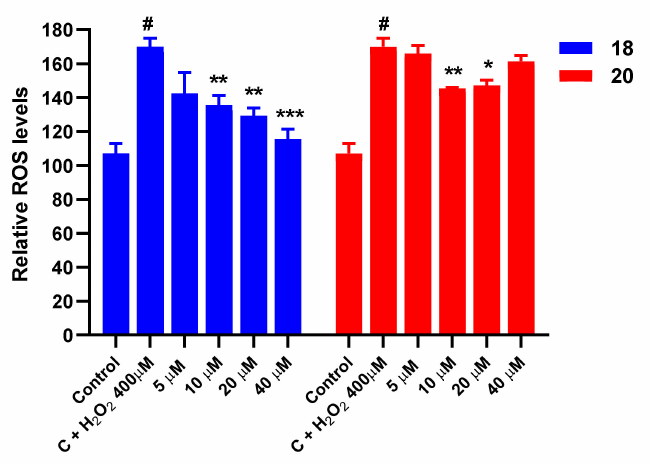
Figure 17. Intracellular ROS level reduction by compounds 18 and 20 in SH-SH5Y under 4-h treatment with 400 µ M H 2 O 2 . Cells were treated with 18 and 20 for 24 h prior to exposure to H 2 O 2 . ROS levels were evaluated by the DFCH-DA method. Data are presented as the Mean ± SEM of three independent experiments carried out in quadruplicate. # p <0.001 vs. vehicle-treated control. * p < 0.05, ** p < 0.01, *** p < 0.001 vs. only with H 2 O 2 -treated